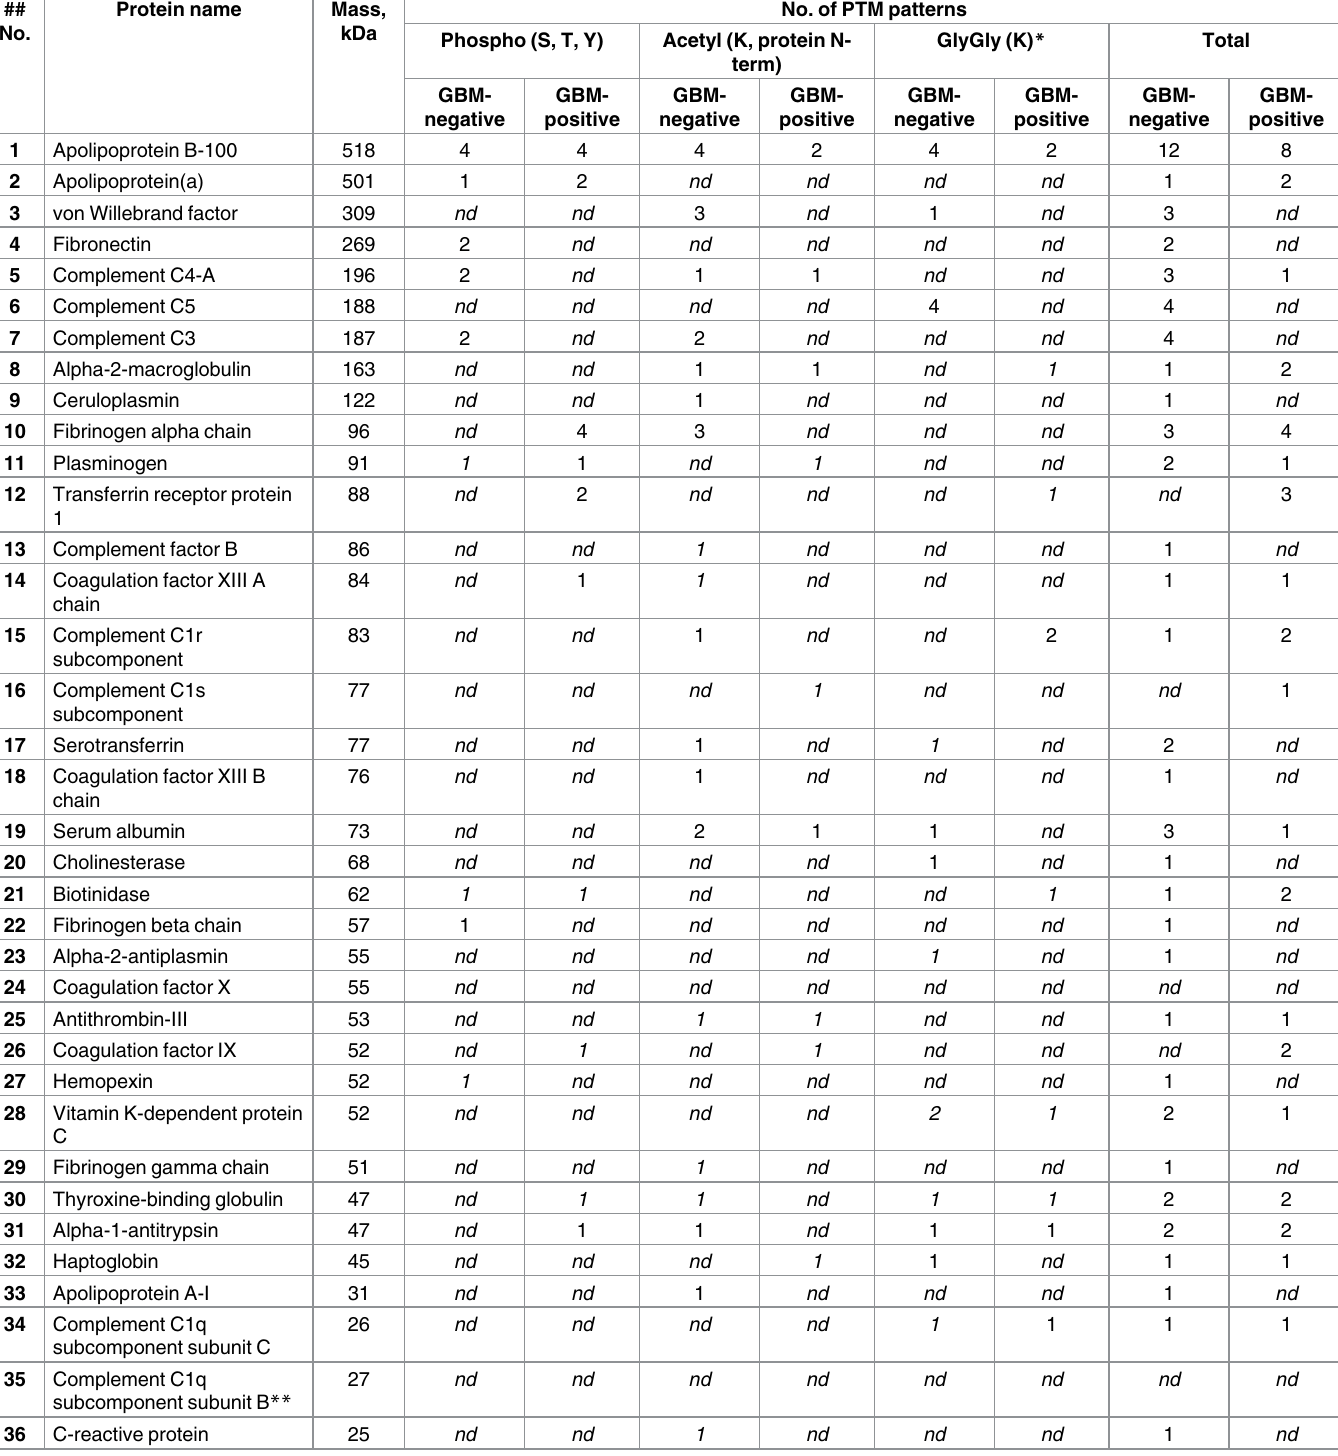
Table 4. GBM-negative and GBM-positive patterns’ counted for FDA-approved plasma proteins. ##